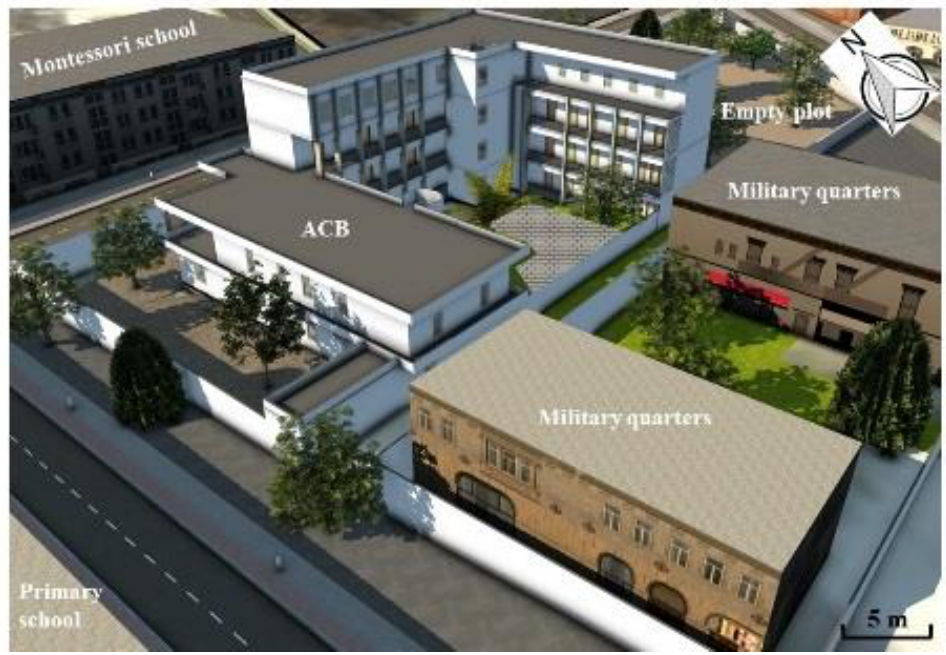
Figure 4. Isometric view of the U-shaped case study ACB’s 3D model, with surrounding buildings.